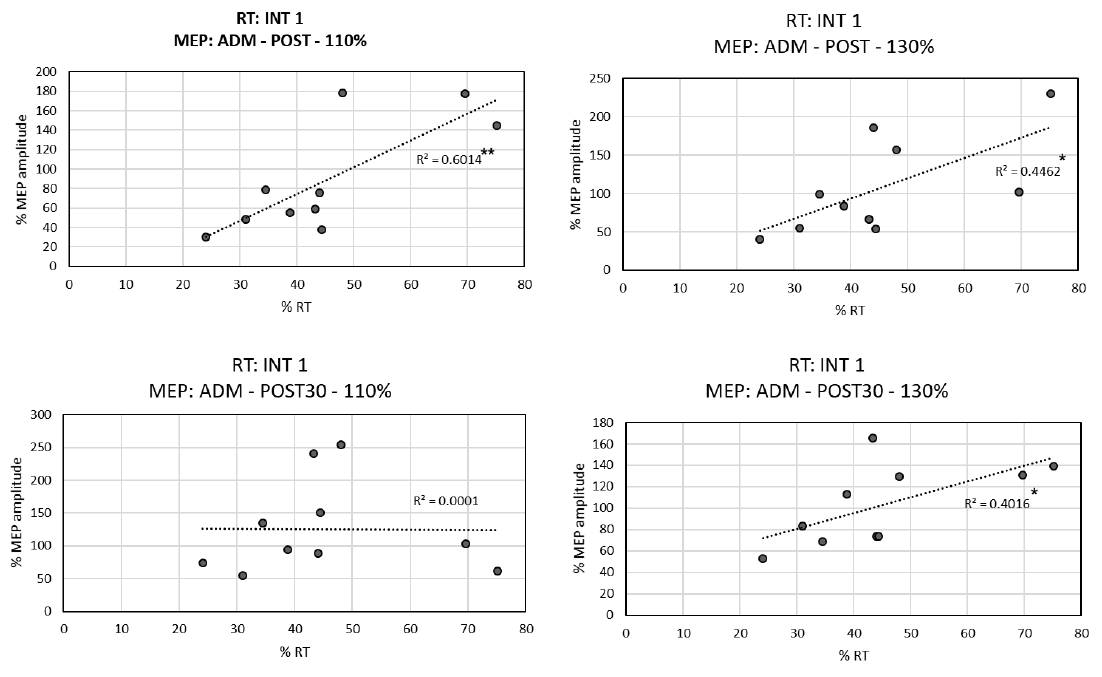
Figure 5. Active group correlation between the % of MEP amplitude and the % of RT based on Pre-Assessment time. Simple linear regression and the coefficient of determination of the correlation of behavior RT performance in the first intervention with MEP amplitudes of ADM in Post- and Post-30’-Assessment at 110% and 130% RMT. R and p -value are reported in the results. * corresponds to significance between p = 0.05 and p = 0.01; ** correspond to significance below p = 0.01. For the Sham group (Figure 6), a tendency towards negative linear correlation was observed between the RT of the Int1 and the amplitude of MEP induced in the ADM muscle at Post-Assessment at 110% RMT intensity (r = −0.495, p = 0.122), at 130% of RMT intensity (r = −0.575, p = 0.064), and at Post-30′-Assessment time at 130% of RMT (r = −0.559 p = 0.074). This indicated that the higher the MEP amplitude in the ADM muscle, the shorter the RT.